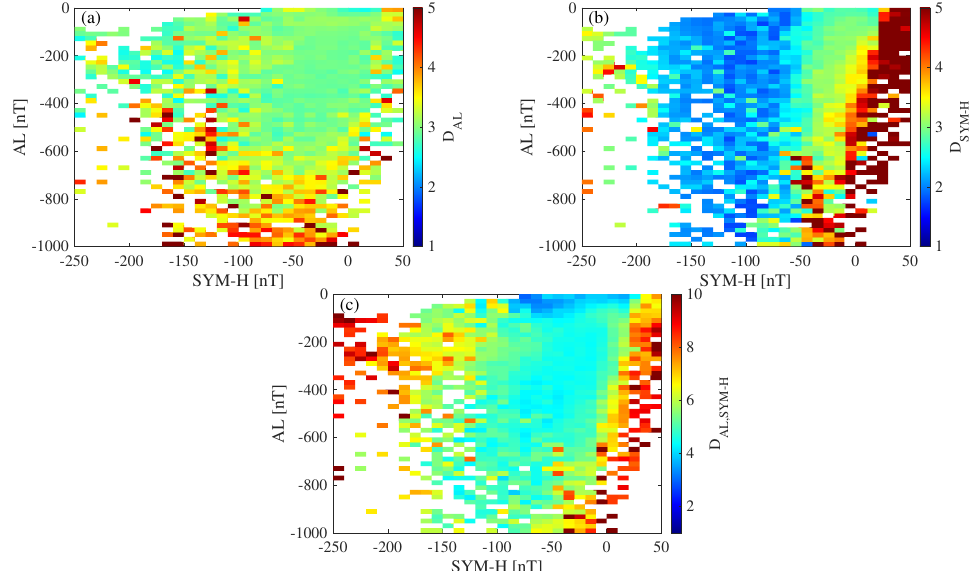
Figure 5. Instantaneous dimension D as a function of the values of both geomagnetic indices. Panels ( a , b ) refer to the univariate time series, while panel ( c ) corresponds to the bivariate one. When independently considered, the instantaneous dimensions D AL and D SYM − H clearly show different behaviors depending on the values of both